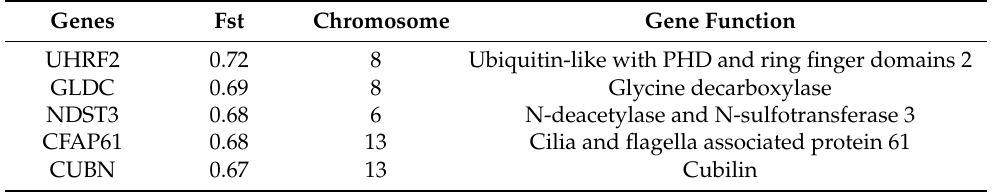
Table 4. Estimated chromosomes and genes under selection using F ST